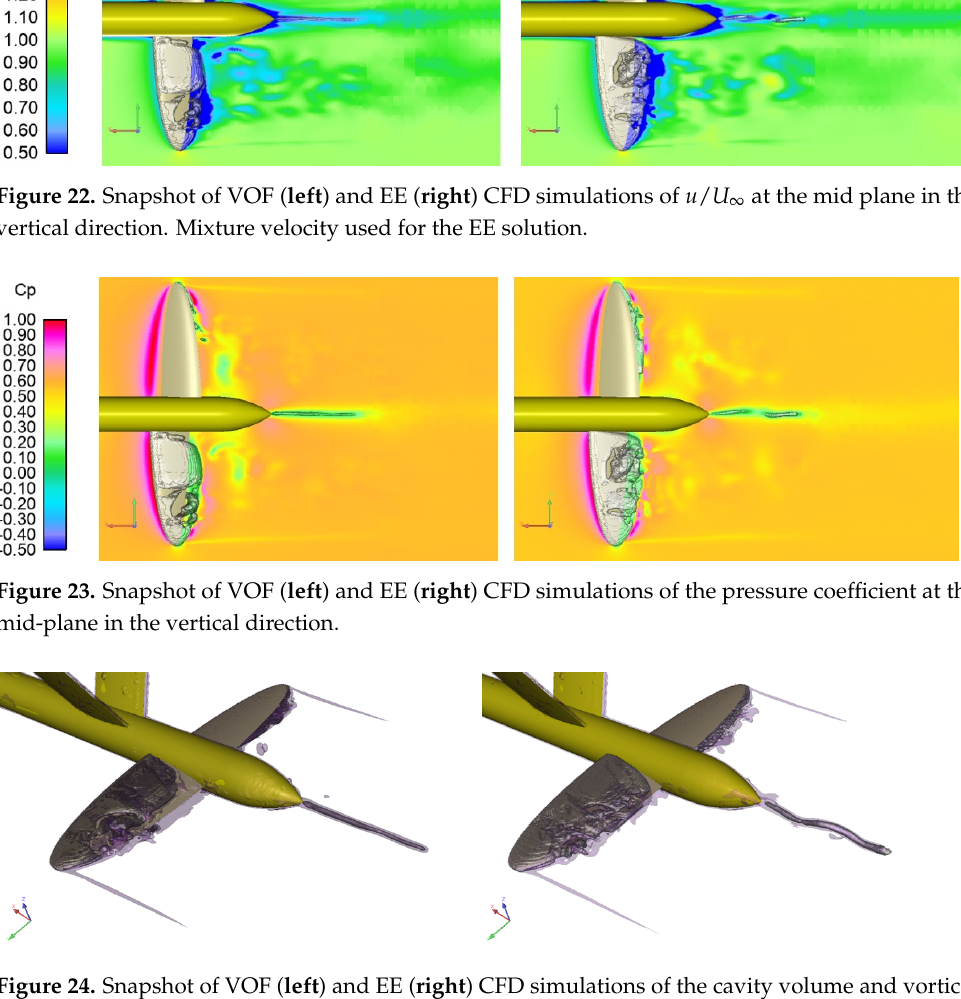
Figure 24. Snapshot of VOF ( left ) and EE ( right ) CFD simulations of the cavity volume and vortical structures with | Ω ∗ | = 10 as